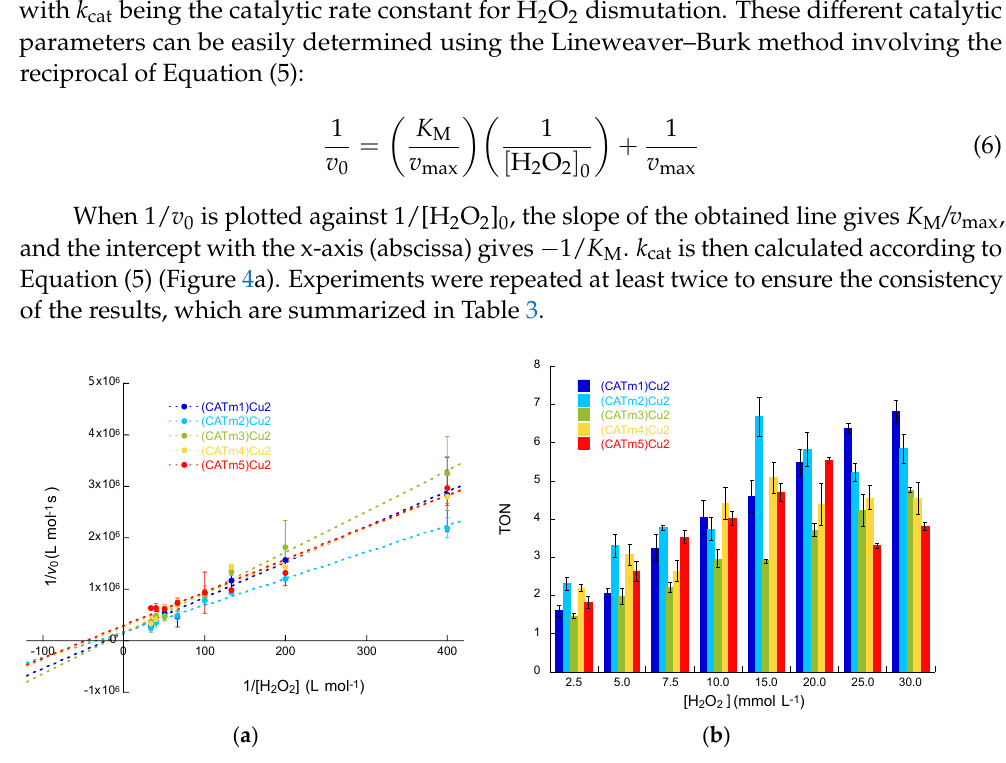
Figure 4. Catalytic behavior of the five CATmx:Cu 1:2 complexes in MOPS (50 mM, pH 7.5) at 25 °C. Experiments were performed with [(CATmx)Cu 2 ] = 100 µM (x = 1 – 5). ( a ) Lineweaver – Burk plot (double reciprocal of the Michaelis – Menten equation), allowing the determination of enzyme kinetic parameters. ( b ) Turnover numbers (TONs) of dismutated H 2 O 2 measured at various [H 2 O 2 ] concentrations. Data are given as the average of at least 2 experiments ± standard error of the mean (SEM). Notably, kinetics values for [(CATm1)Cu 2 are slightly different from previously reported data [19] since, in this work, kinetics were measured in a larger [H 2 O 2 ] concentration range, which led to a different slope in Figure 4a.